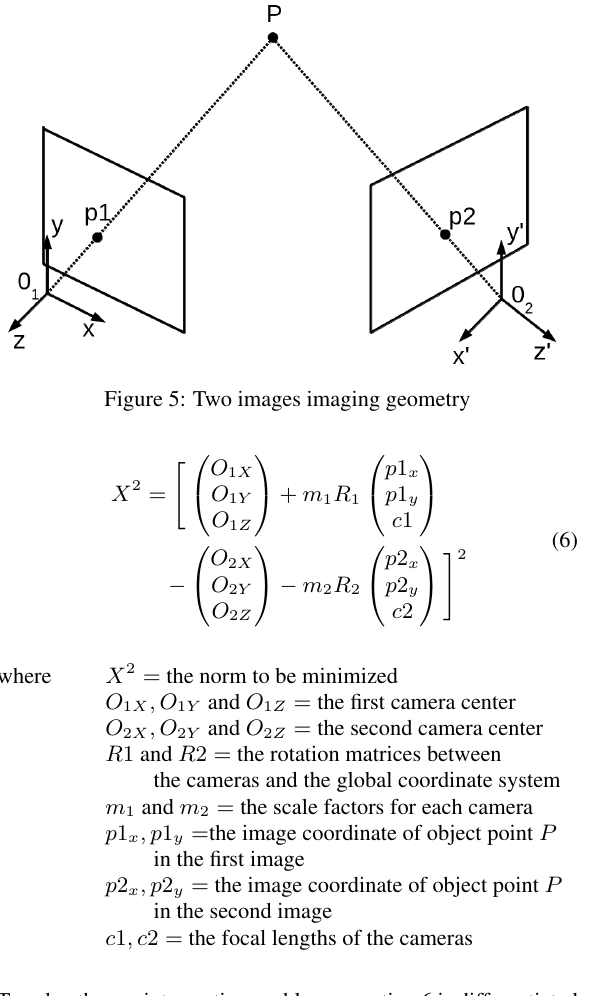
used LROC images of 1576 and 1577 with 0.51 meters per pixel ground resolution. The two right images, the two left images and one right/left image pair were matched to provide DTMs